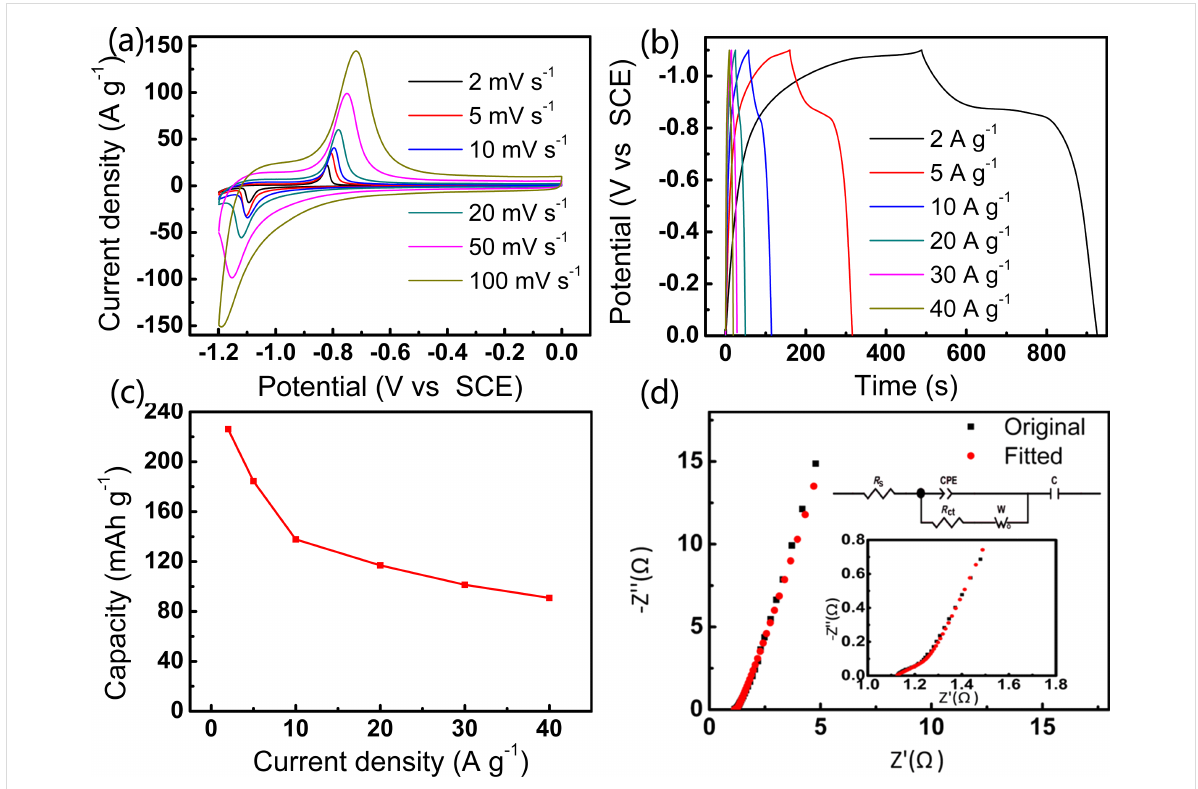
Figure 4: Electrochemical performance of the CC-CNT@Fe 2 O 3 electrode: (a) CV curves; (b) GCD curves; (c) capacity versus current density; (d) EIS curves.